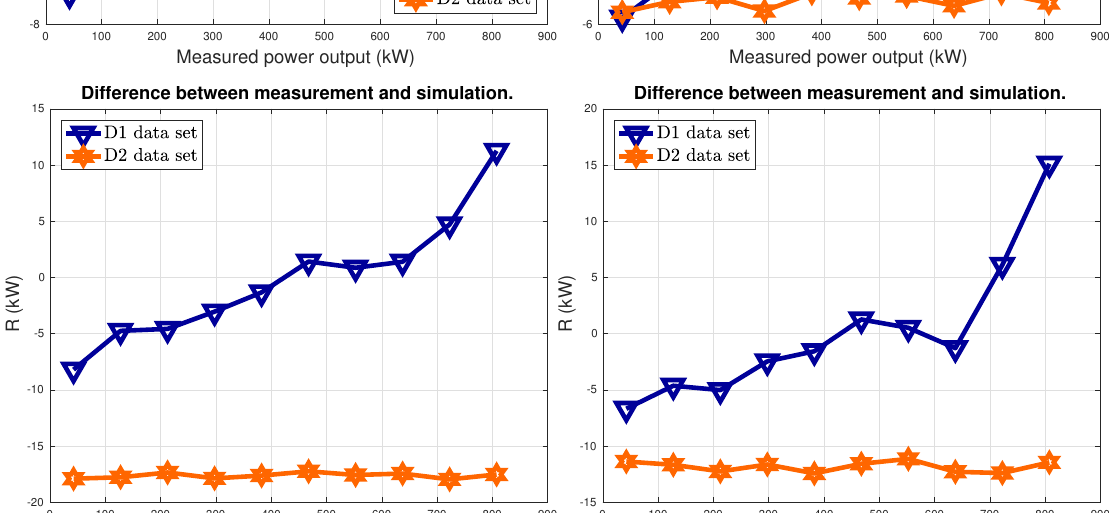
Figure 3. The average difference R between power measurement Y and estimation ˆ Y (Equation (14)). Data sets, respectively: 2008 vs. 2012, 2013, 2014, 2015, 2017,